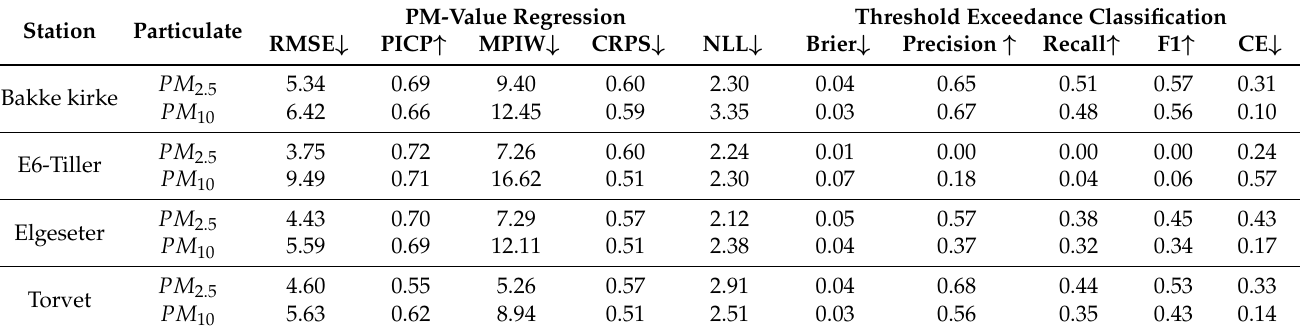
Figure 14. Predicting the threshold exceedance probability of air pollutants level using a standard neural network with MC dropout. Table 3. Summary of performance results when forecasting the PM-value and threshold exceedance using a standard neural network with MC